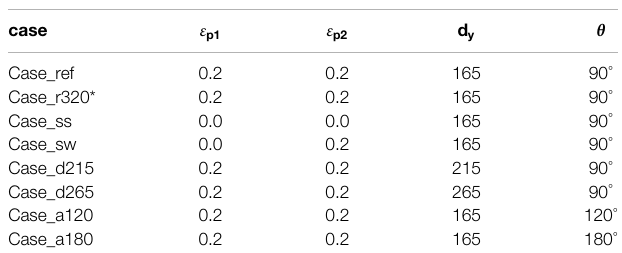
TABLE 2| Parametervaluesforcasesinthisstudy. ε p 1 and ε p 2 representtheinitial plastic strains of Arc1 and Arc2, respectively. d y represents the maximum depth that the front of the subducting plate can reach initially and the unit of d y is km. θ is the initial angle of subduction cusp ( Figure 2A ). All parameters